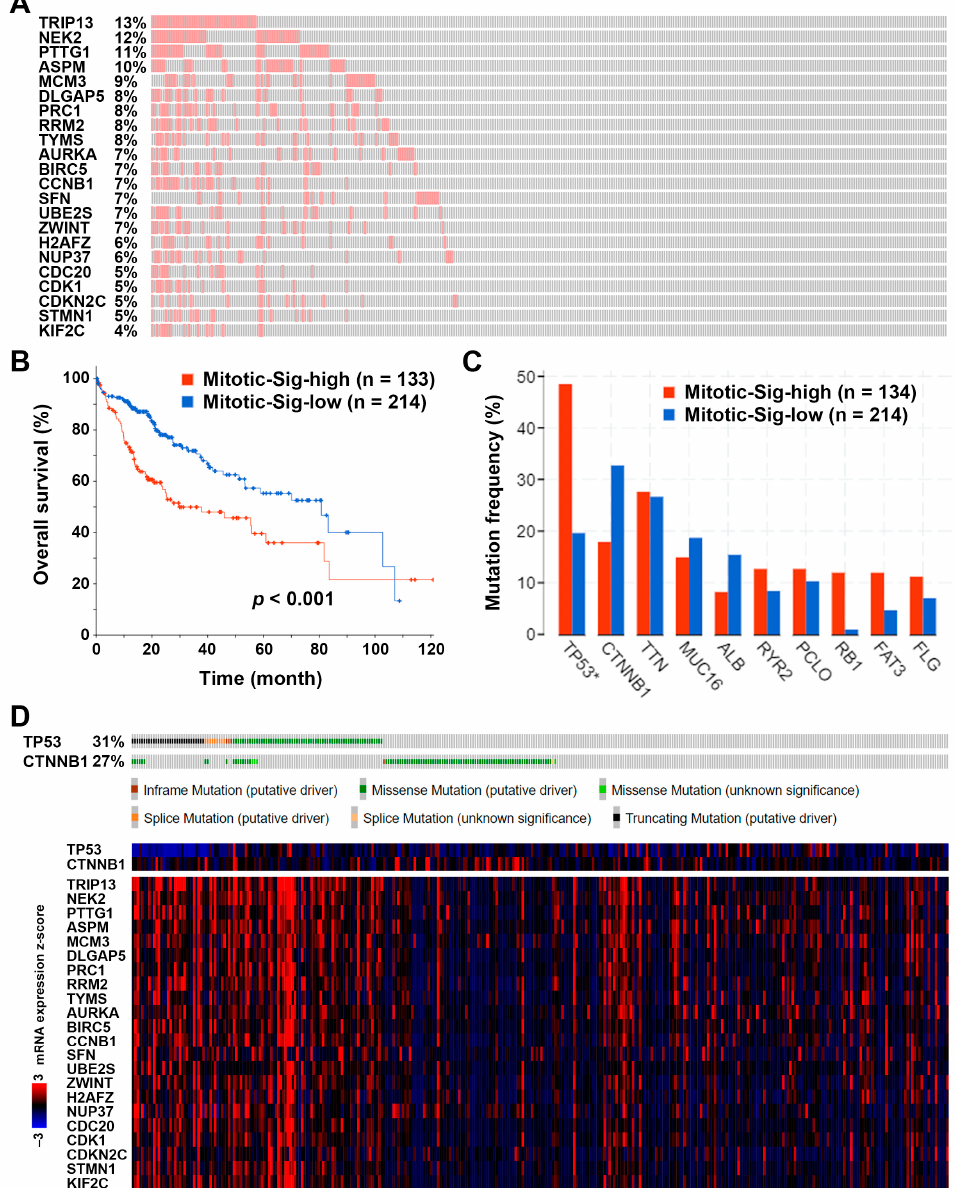
Figure 3. The association between the prognostic mitotic gene signature and gene mutations in hepatocellular carcinoma. ( A ) A waterfall plot shows the mRNA upregulation of the mitotic gene signature in HCC patients. ( B ) The prognostic impact of the mitotic gene signature expression on the overall survival of HCC patients. ( C ) The gene mutation frequency in HCC patients with high or low expression levels of mitotic gene signature. * indicates significant differences ( p < 0.05) between two groups. ( D ) Upper: The genetic mutation statuses of TP53 and CTNNB1 genes in HCC patients. ( D ) Lower: The heat map for the mRNA expression levels of TP53 , CTNNB1 , and mitotic gene signature.